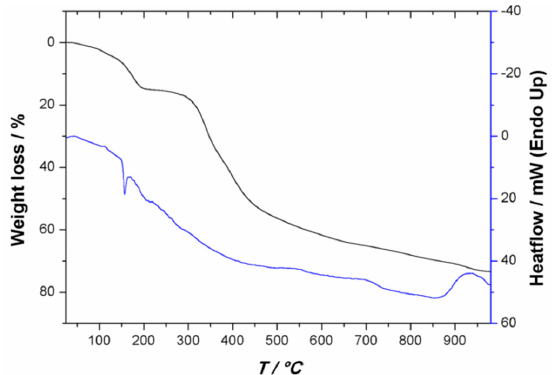
Figure 3. Thermogravimetric (right axis) and thermodifferential (left axis) analysis of NdMurex performed under N 2 atmosphere.